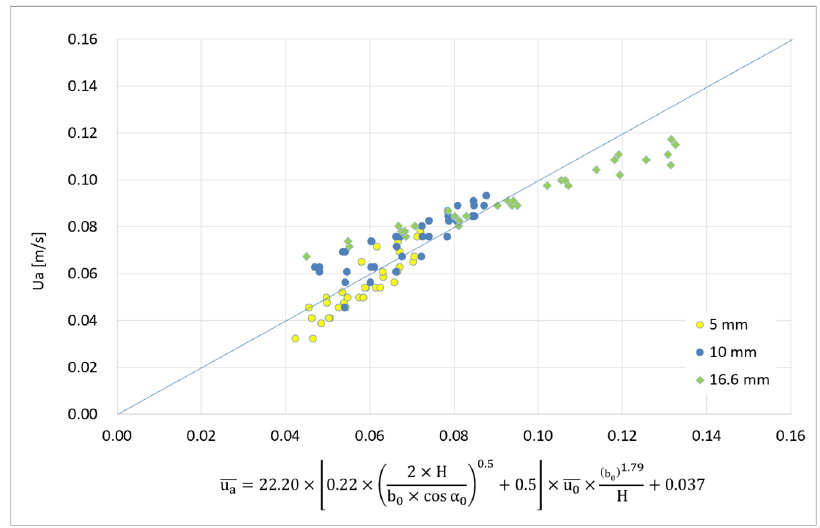
Figure 11. Least square fit for the full set of test results for visual aerodynamic sealing of the air curtain.